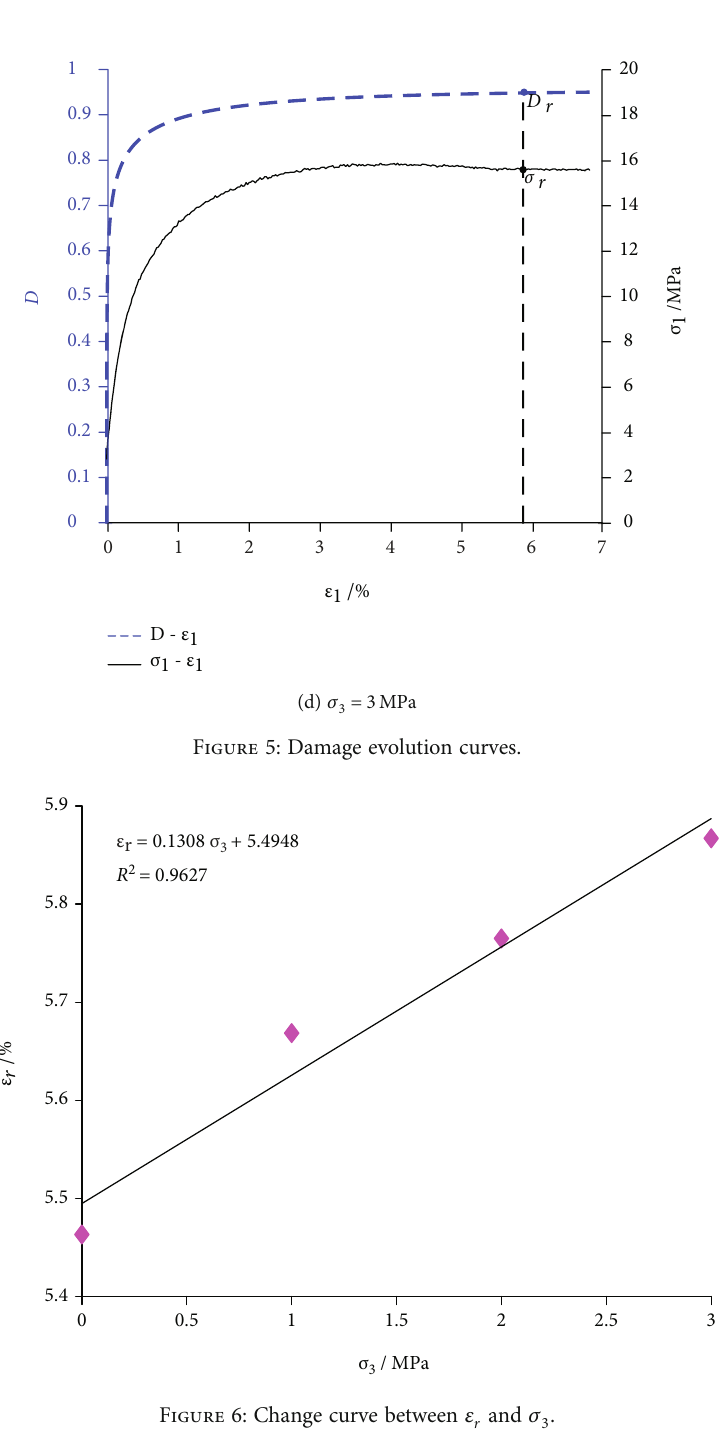
Figure 6: Change curve between ε